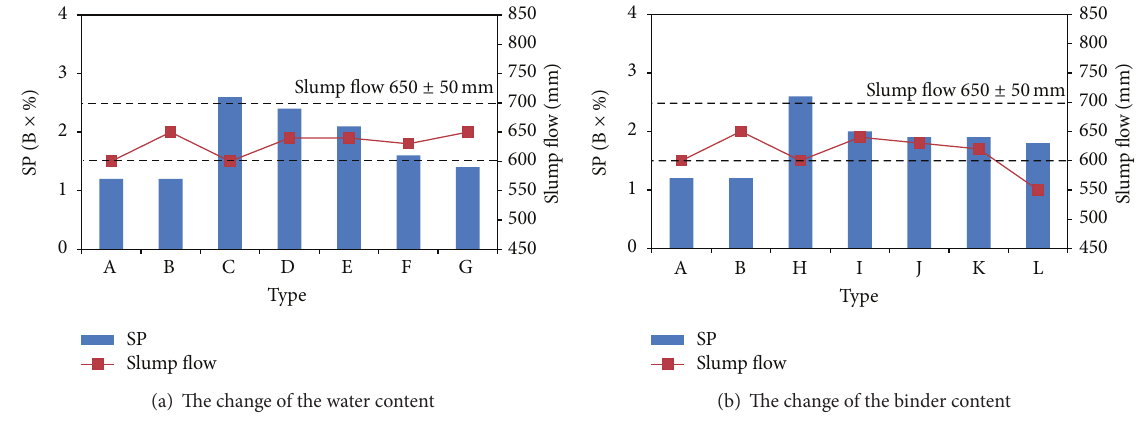
Figure 1: The fluidity of high volume fly ash HFC with superplasticiser content.